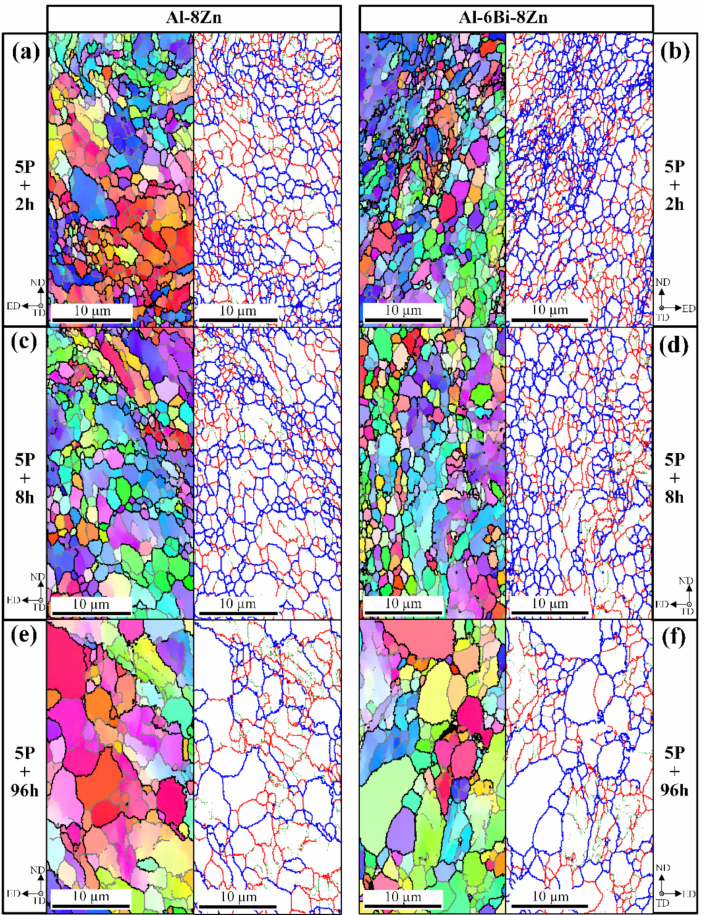
Figure 4. EBSD IPF maps and boundary maps of the annealed (at 200 ◦ C) Al-8Zn and Al-6Bi-8Zn alloys. ( a , b ) 2 h, ( c , d ) 8 h, and ( e , f ) 96 h. In boundary maps, green, red, and blue lines depict boundaries with misorientations in the rage of 2 ◦ ≤ θ < 5 ◦ , 5 ◦ ≤ θ < 15 ◦ , and 15 ◦ ≤ θ < 180 ◦ ,